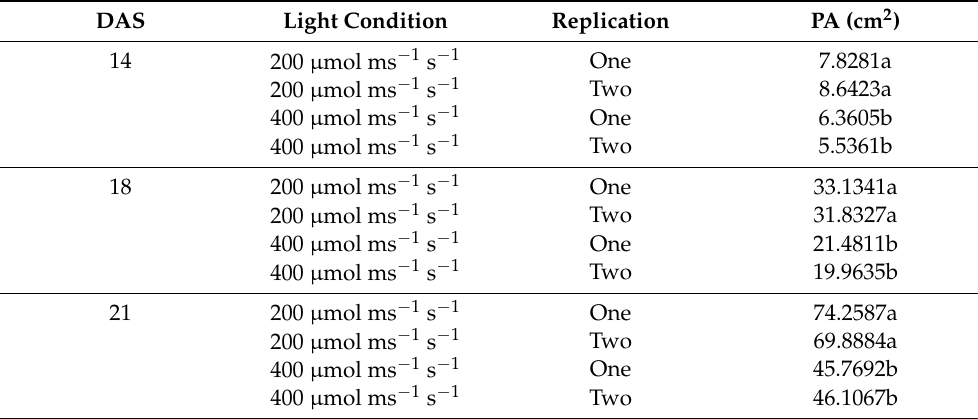
Table 2. Comparing projected area (PA) of green lettuce at two lighting conditions on multiple days after sowing (DAS). Values in the same column followed by a different letter are significantly different ( p <